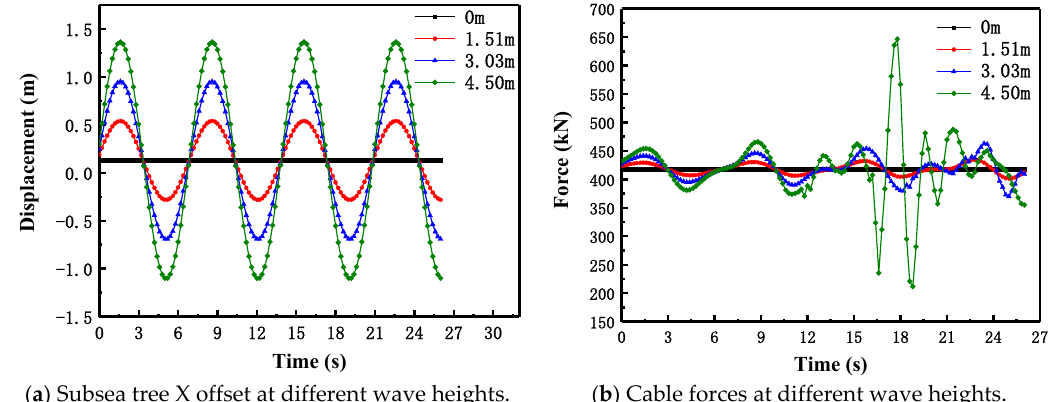
( b ) Cable forces at different wave heights. Figure 9. Subsea tree offset and cable forces at different wave heights.